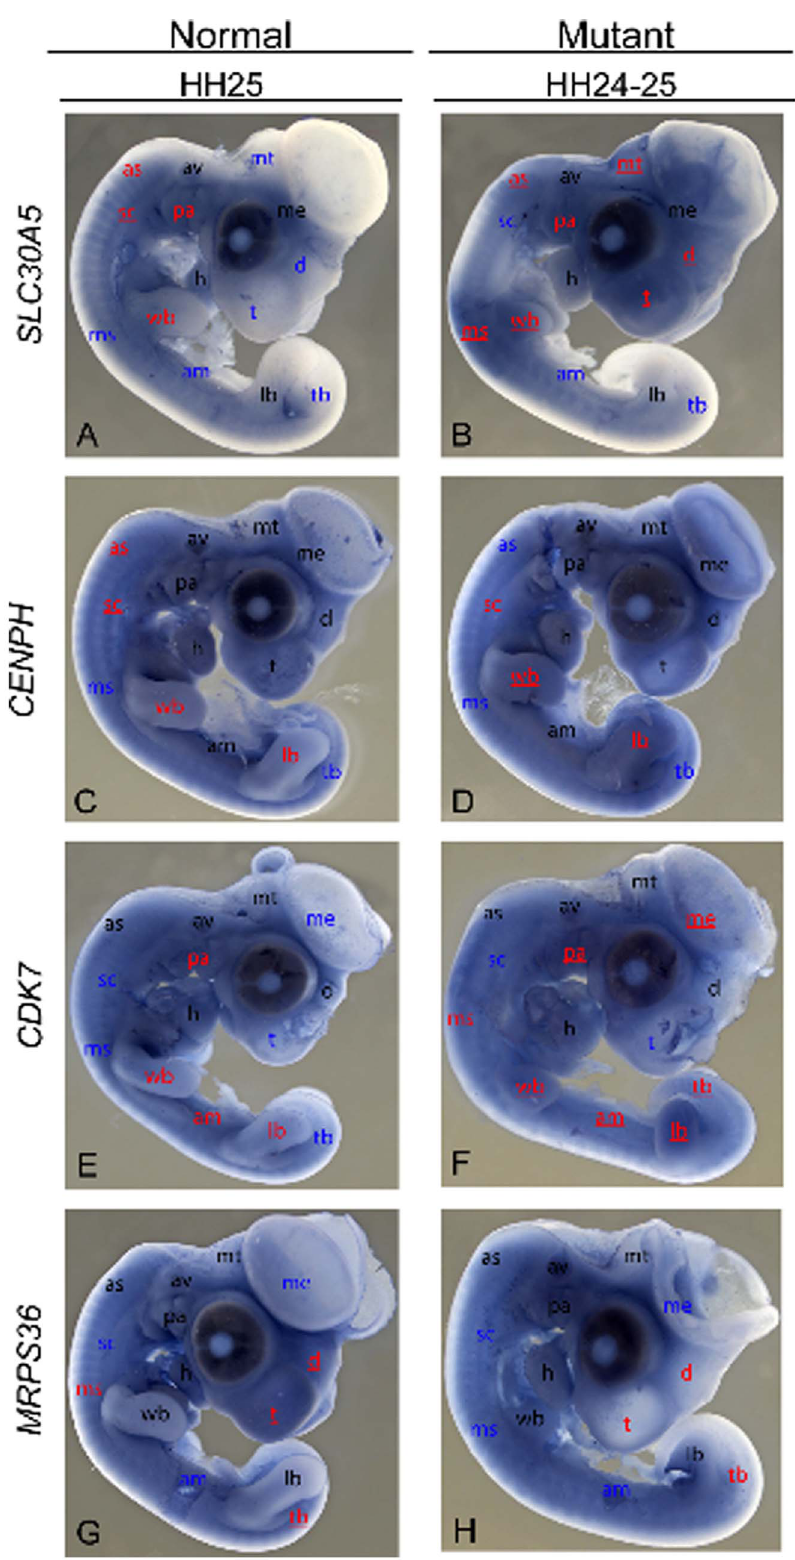
Figure 3. Differential gene expression in normal and mutant embryos from the coloboma line. Localization of chicken SLC30A5 , CENPH , CDK7, and MRPS36 gene expression in HH stage 24–25 in normal and mutant chicken embryos using whole-mount in situ hybridization. See the Results and Discussion sections for expanded explanations. ( A ) Normal coloboma embryo (HH25) with SLC30A5 expression. ( B ) Mutant SLC30A5 embryonic expression (HH24) is similar to that of the normal embryo except for increased expression in the telencephalon, pharyngeal arches, wing